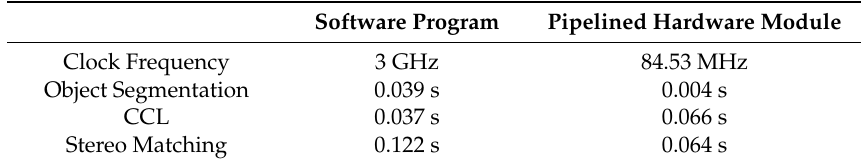
Table 5. Comparison of time needed to process a 640 × 480 color image using a software program or hardware